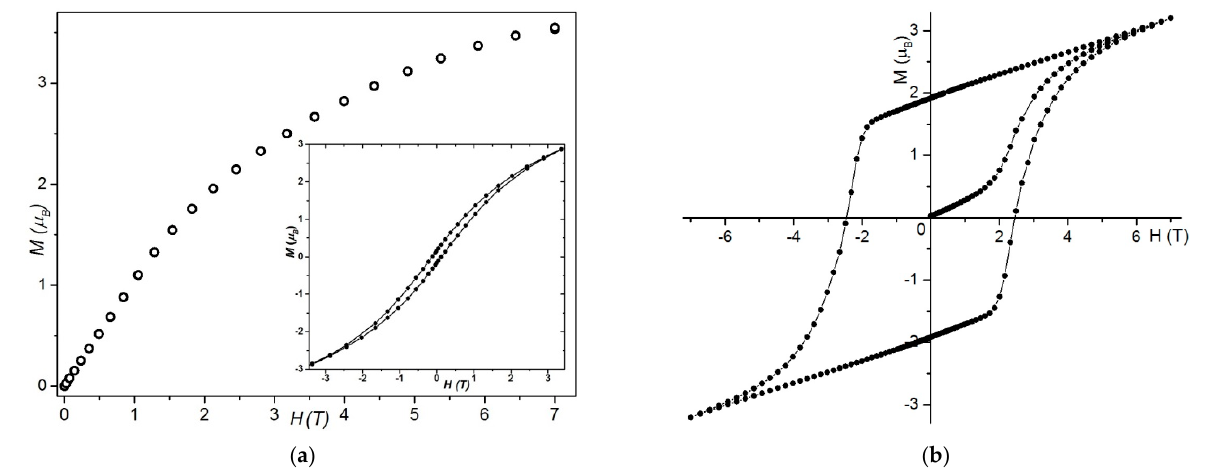
Figure 23. Magnetization plots at 1.8 K and a field sweep rate of 700 Oe/s. ( a ) Initial magnetization vs. the field plot and magnetic hysteresis (inset) for 14 . ( b ) Initial magnetization vs. the field plot and magnetic hysteresis for 15 [56].